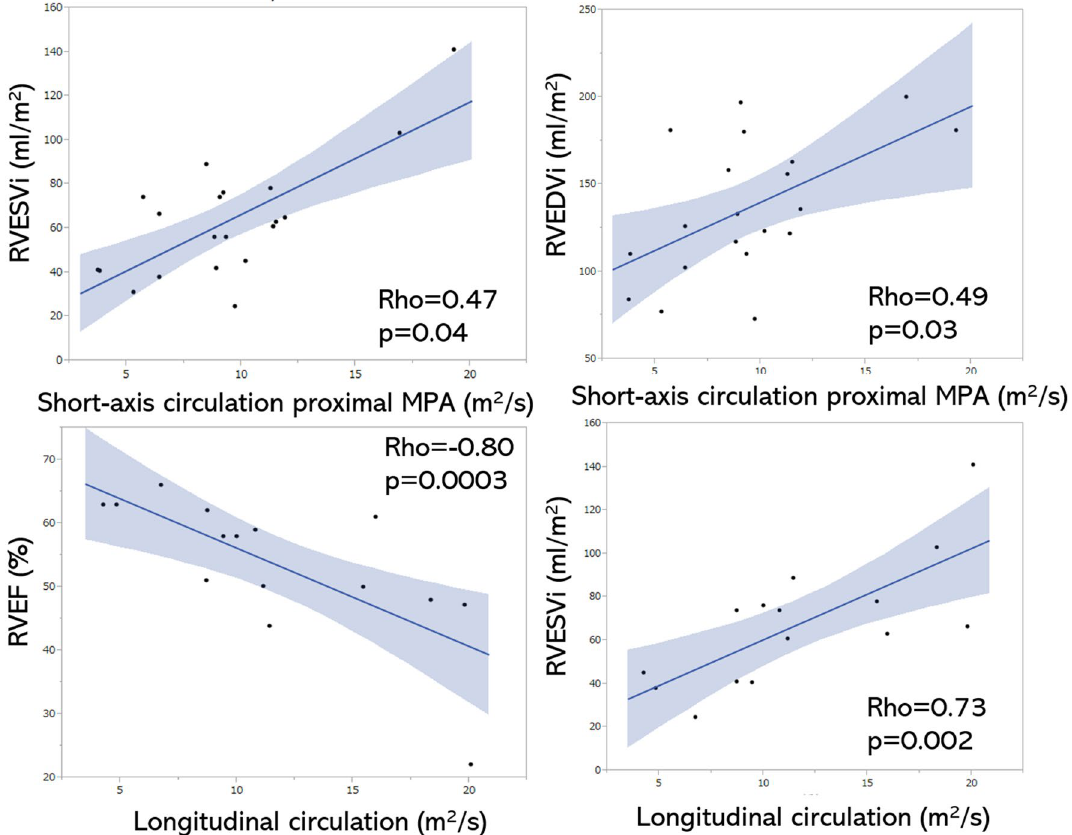
Figure 6. Correlations between integral circulation and RV functions. The short-axis integral circulations in the proximal MPA show significant positive correlations with RVESVi and RVEDVi (upper 2 graphs). The longitudinal integral circulation shows a negative correlation with RVEF and a positive correlation with RVESVi (lower 2